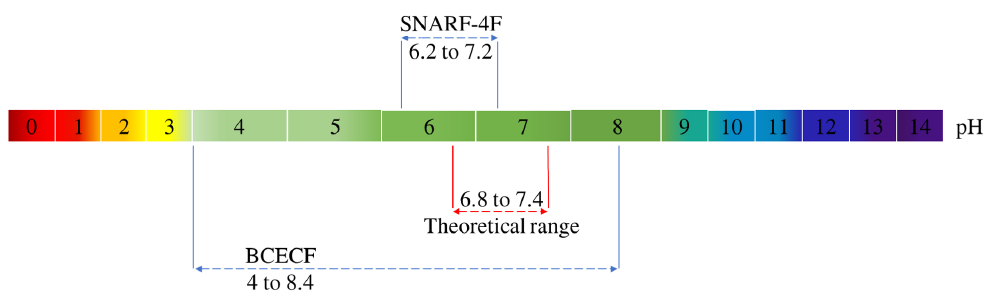
Figure 10. pH drift measured with BCECF and a pH-meter. Measurements with SNARF-4F are outside the range of validity of this probe which explains its poor performance.